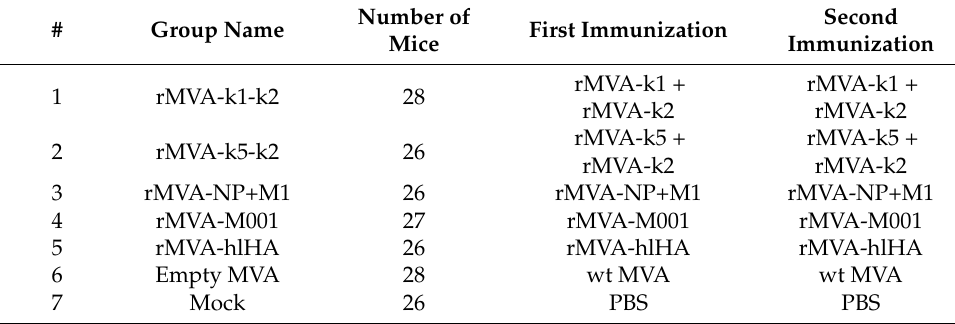
Table 3. Groups of mice with immunization